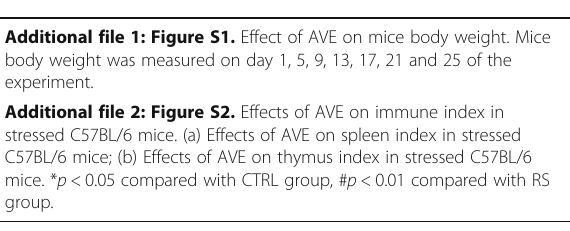
Additional file 1: Figure S1. Effect of AVE on mice body weight. Mice body weight was measured on day 1, 5, 9, 13, 17, 21 and 25 of the experiment. Additional file 2: Figure S2. Effects of AVE on immune index in stressed C57BL/6 mice. (a) Effects of AVE on spleen index in stressed C57BL/6 mice; (b) Effects of AVE on thymus index in stressed C57BL/6 mice. * p < 0.05 compared with CTRL group, # p < 0.01 compared with